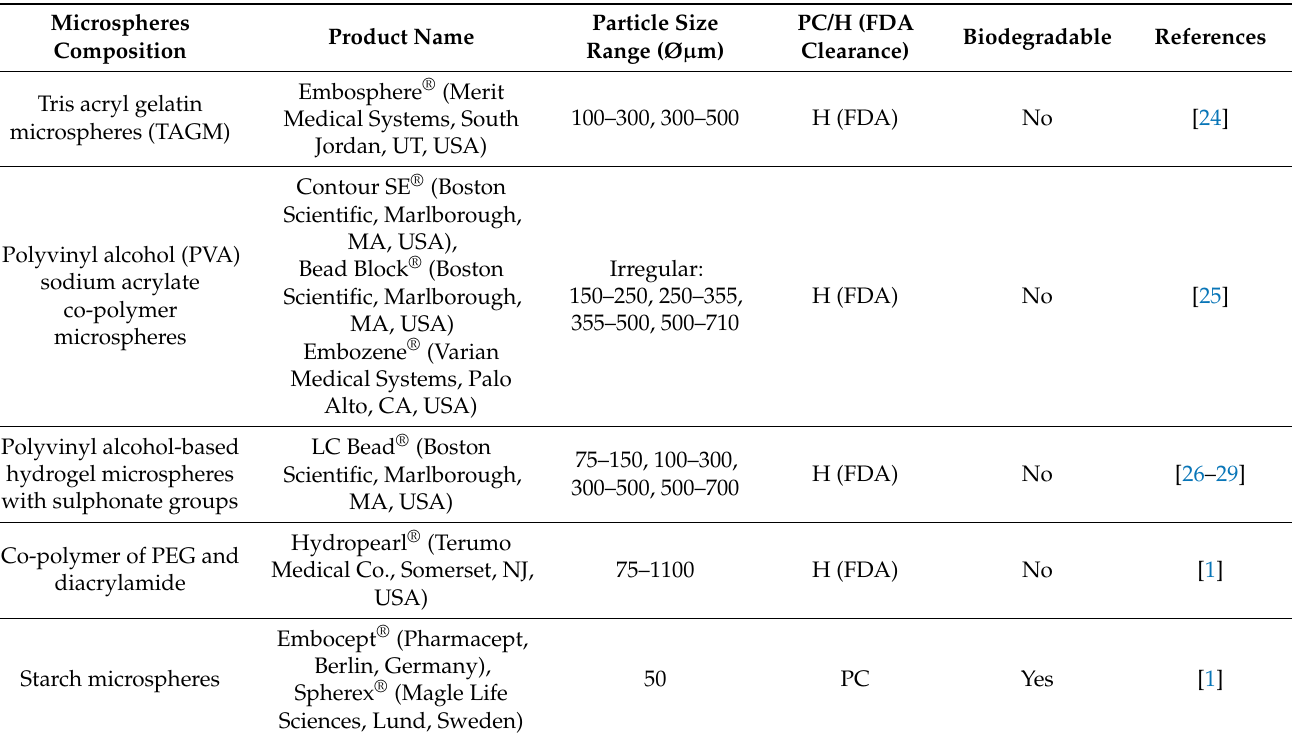
Figure 1. Treatment of hepatocellular carcinoma (HCC) shows the advantages of chemo/radio- embolization drug targeting over systemic drug therapy. Systemic drug therapy ( A ) yields lower tumor targeting and more side effects than local delivery via trans-arterial chemo/radio embolic drug targeting ( B ). Yellow arrows = injection site. Created with BioRender.com. Table 2. Overview of non-functionalized microspheres for hepatic trans-arterial embolization (TAE). PC = pre-clinical use, H = Human use, FDA = FDA approved as an active implantable medical device. See Section 4 for a detailed evaluation of the microspheres.